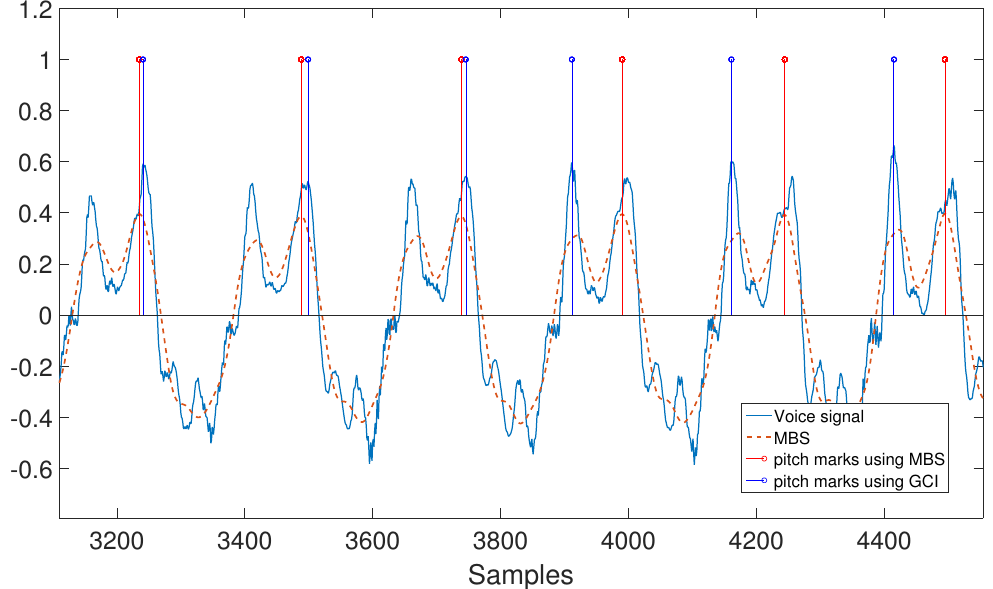
Figure 7. Pitch marking using two different methods. MBS achieves smaller differences between consecutive pitch marks than the glottal closure instant